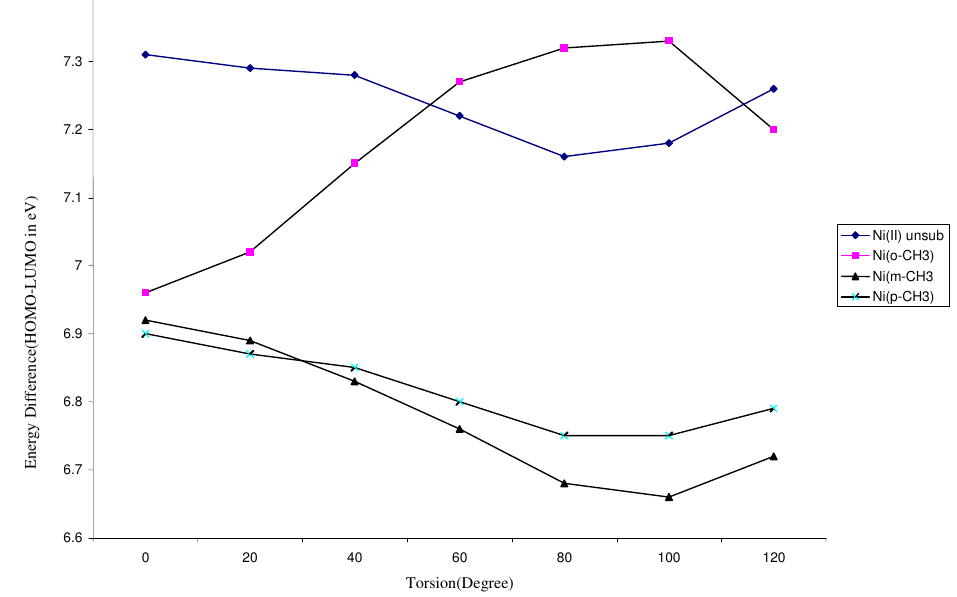
Figure 7. Evolution of HOMO-LUMO energy difference as a function of torsion angles for